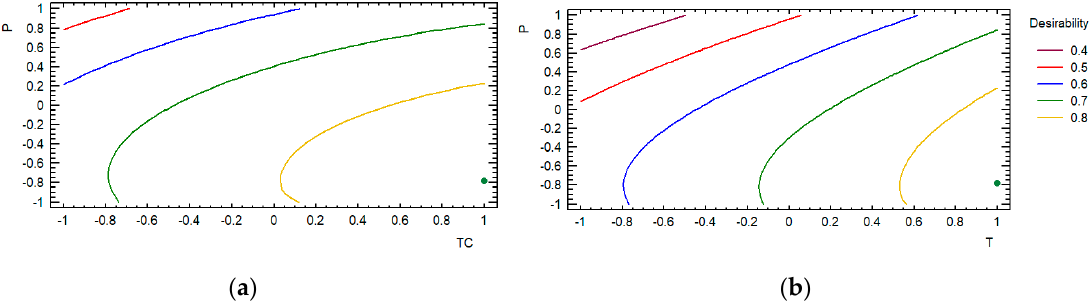
Figure 12. Contours of the response surface of the composite desirability function, ( a ) for temperature maintained at 110 °C, and ( b ) for compaction time maintained at 60 s.